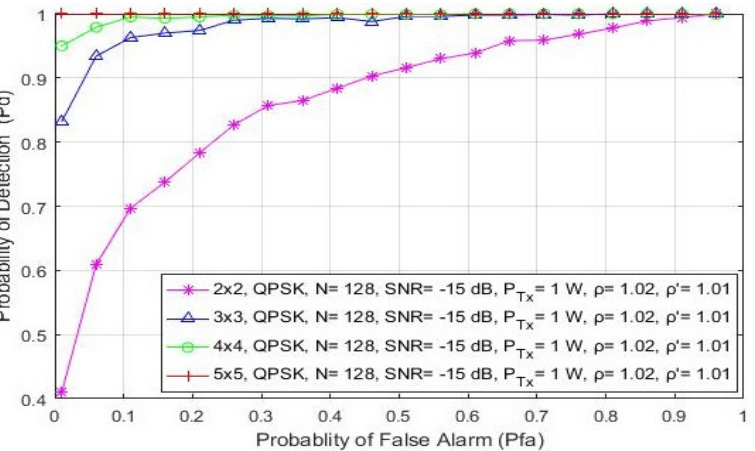
Figure 9. The ROC curves presenting the ED performance for the symmetric 2 × 2, 3 × 3, 4 × 4 and 5 × 5 MIMO-OFDM communication systems.